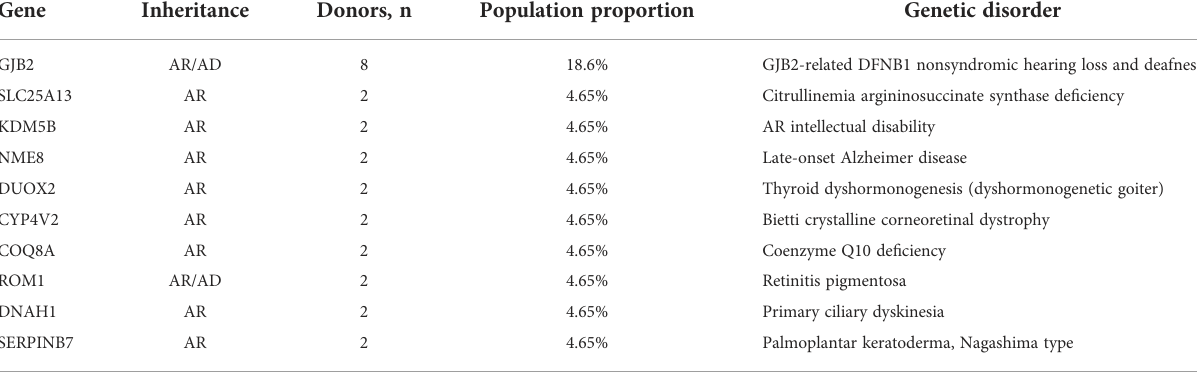
TABLE 3 Whole-exome sequencing detection of identical carrying genes in 43 sperm